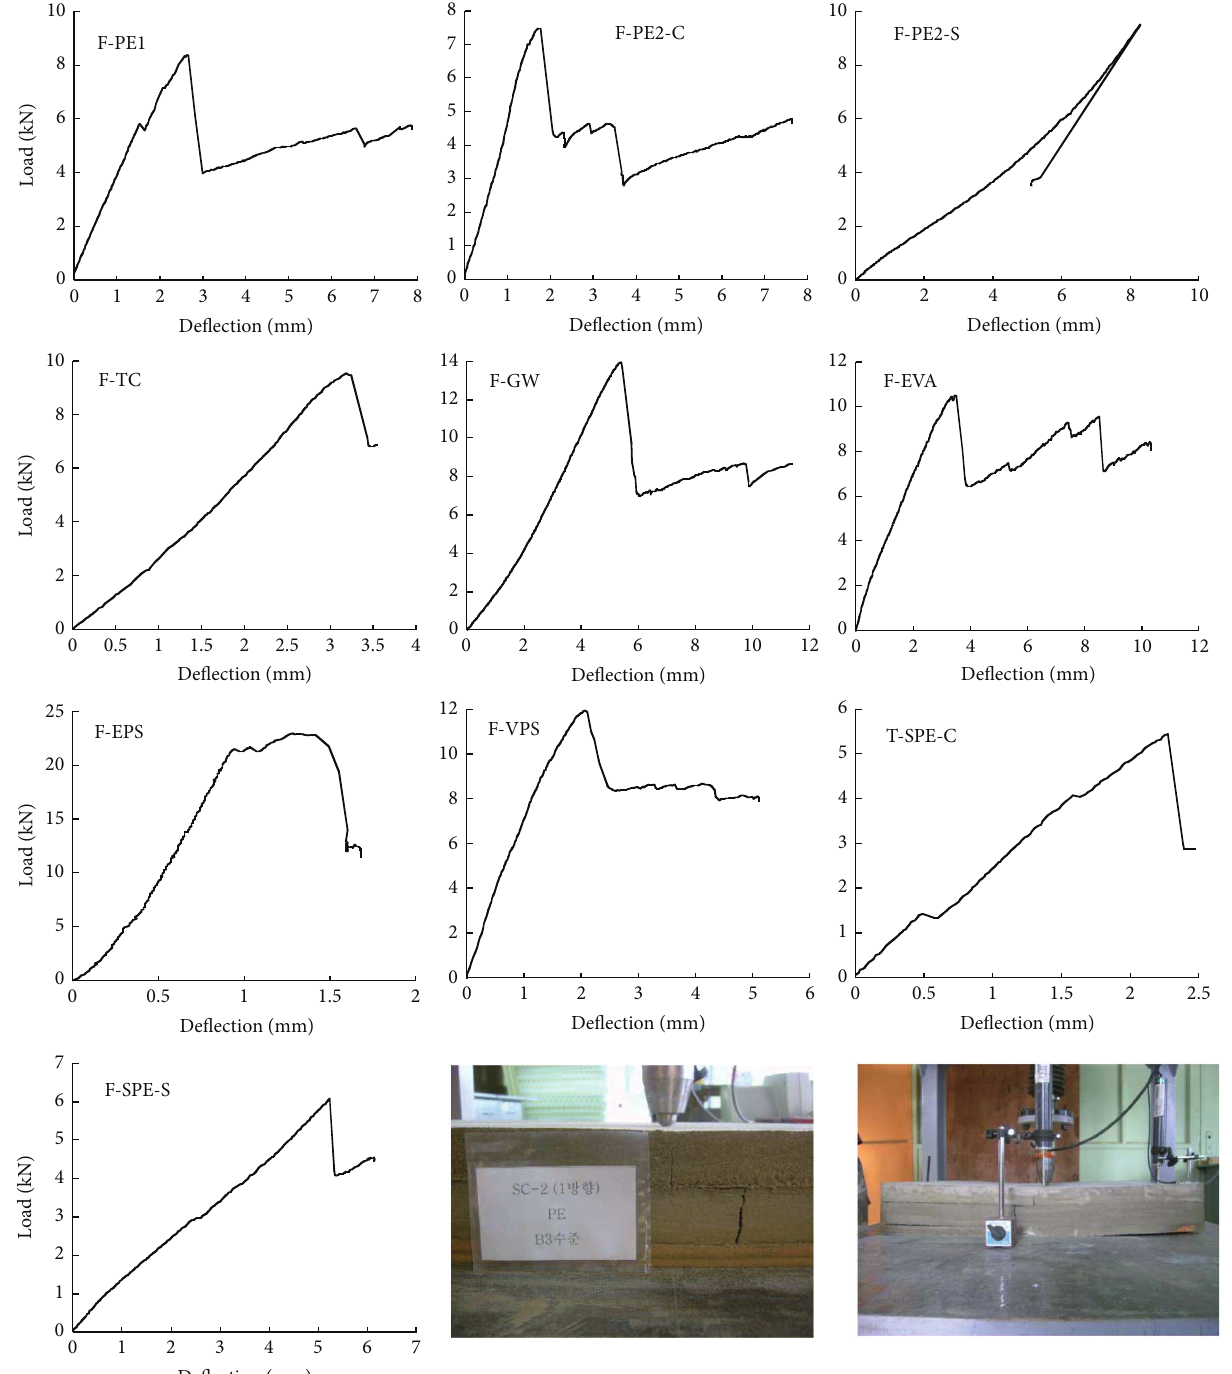
Figure 4: Load and deflection curves of the tested floating